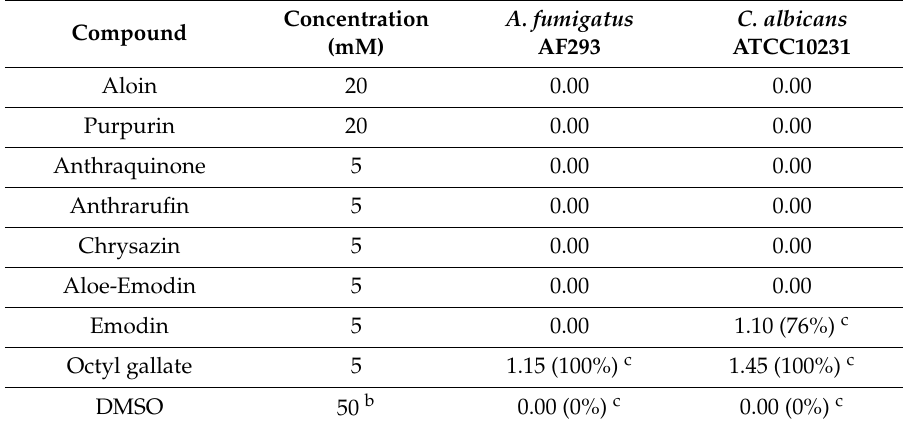
Table 4. Activity of anthraquinone and derivatives against pathogenic fungi. The table shows the calculated zone of inhibition (mm) for each anthraquinone and substituted derivative at the designated concentration a . Concentration Compound (mM)